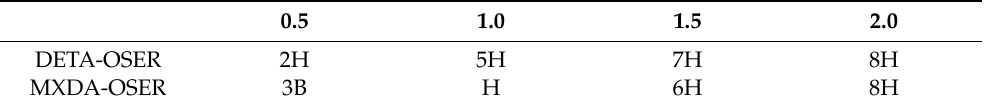
Figure 3. Optical microscope images of the scratches on various coatings. ( a ) DETA-OSER, scratched with an 8H pencil. ( b ) DETA-OSER, scratched with a 9H pencil. ( c ) MXDA-OSER, scratched with an 8H pencil. ( d ) MXDA-OSER, scratched with a 9H pencil. ( e ) NH 3 -OSER, scratched with a 3B pencil. ( f ) TM, scratched with a 6B pencil. Table 1. Pencil hardness of DETA-OSER and MXDA-OSER in different molar ratios: H:epoxy.